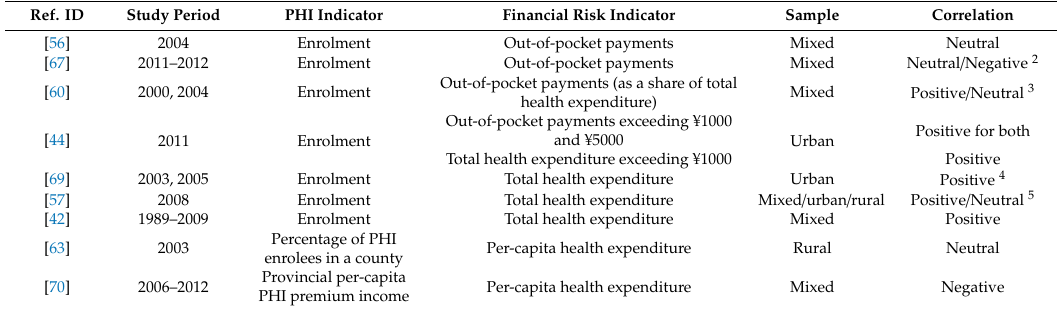
Table 5. The correlation between PHI and financial risk 1